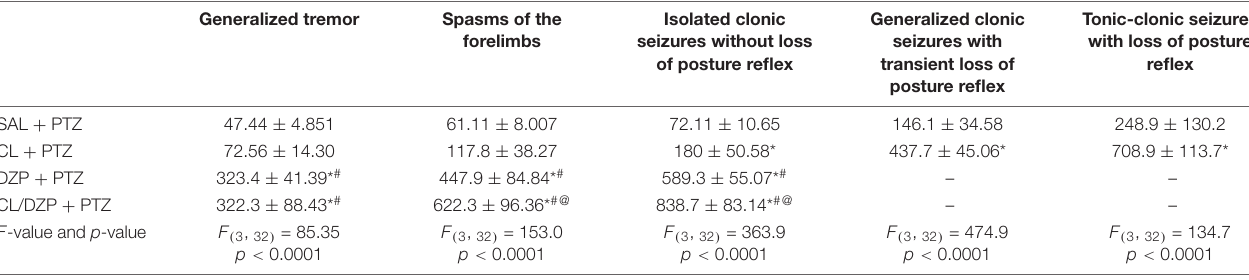
TABLE 1 | Description of the seizure-related behavior of animals treated with Curcuma longa and/or diazepam. Generalized tremor Spasms of the forelimbs